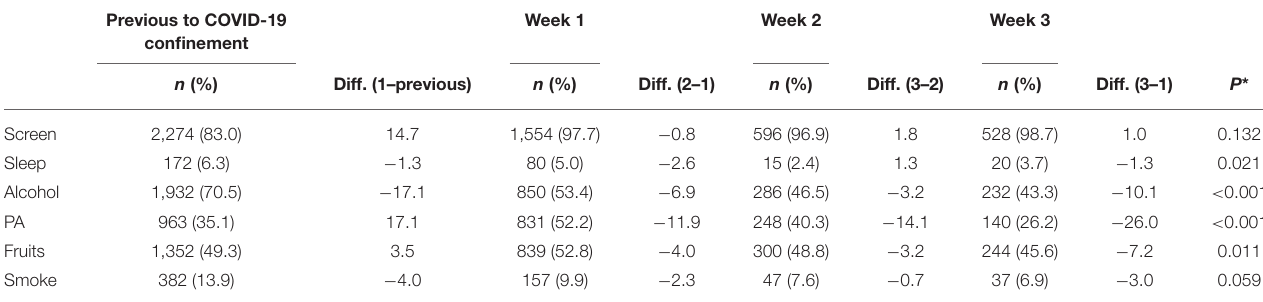
TABLE 3 | Percentage of participants with each health risk behavior previous to and during the COVID-19 confinement. Previous to COVID-19 confinement